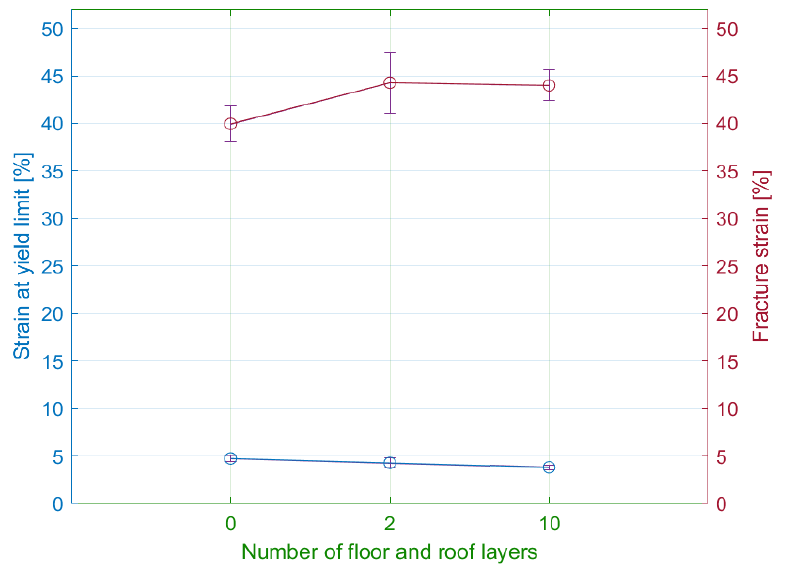
Figure 23. Influence of the number of walls on the strain for the yield limit and fracture strain.